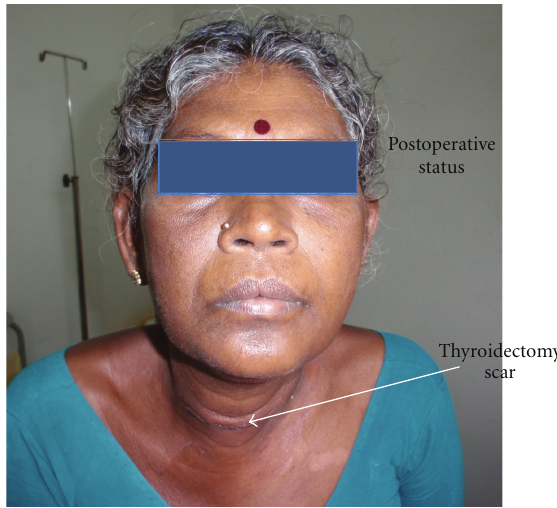
Figure 2: It depicts the postoperative status with the thyroidectomy